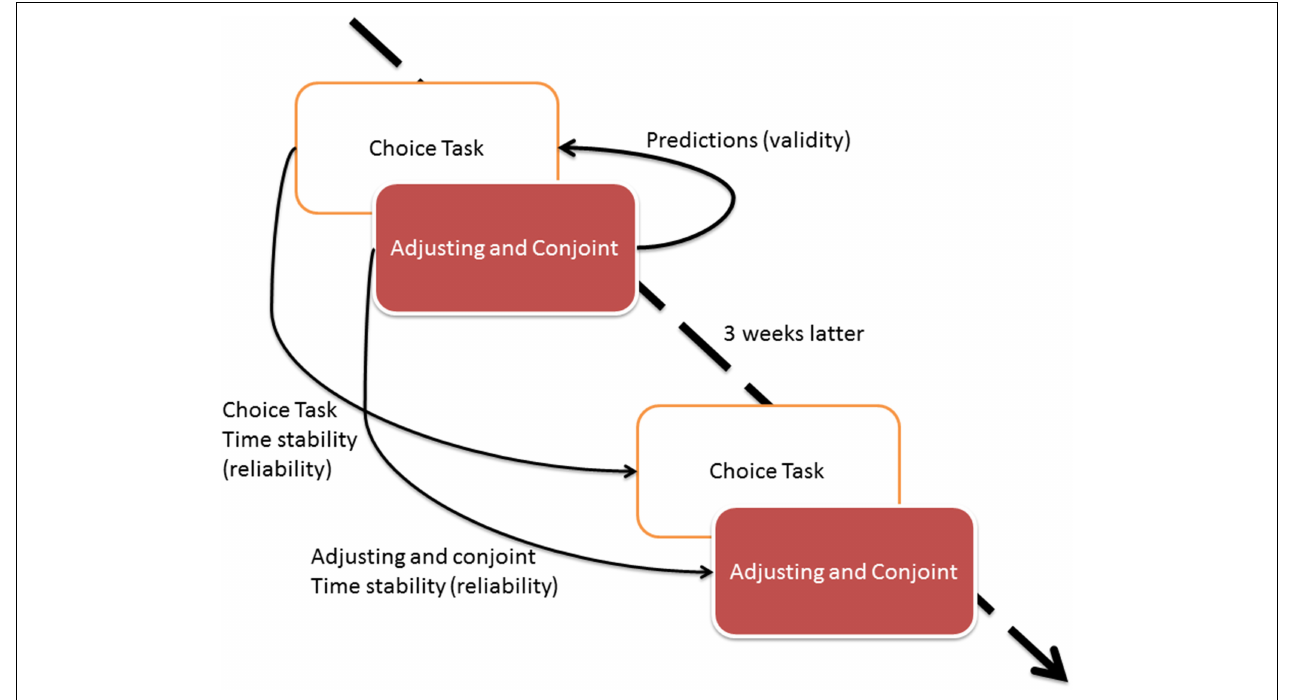
FIGURE 4 | The Study 2 design.